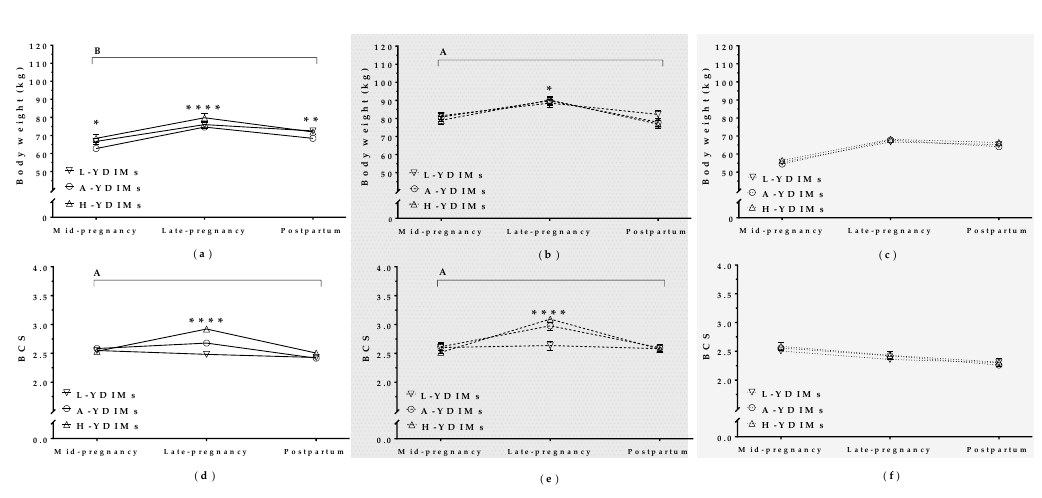
Figure 5. Maternal body weight in ( a ) all ewes, ( b ) mature ewes, and ( c ) maiden sheep showing high, average, or low milk yield at different stages of pregnancy and the postpartum period. BCS in ( d ) all ewes, ( e ) mature ewes, and ( f ) maiden sheep showing high, average, or low milk yield at different stages of pregnancy and the postpartum period. L-YDIMs: low-yielding sheep with a YDIMs (daily milk yield during the first 6 months after lambing) of 1.17 L/d in average; A- YDIMs: average yielding sheep with a YDIMs of 1.90 L/d in average; H-YDIMs: high yielding sheep with a YDIMs of 2.70 L/d in average. Data are mean ± SEM. Significant interactions between pregnancy/postpartum stage and YDIMs are represented by an upper horizontal line (A: p < 0.0001; B: p < 0.01). Asterisks indicate significant differences between groups at each time point (**** p < 0.0001; ** p < 0.01; * p < 0.05).